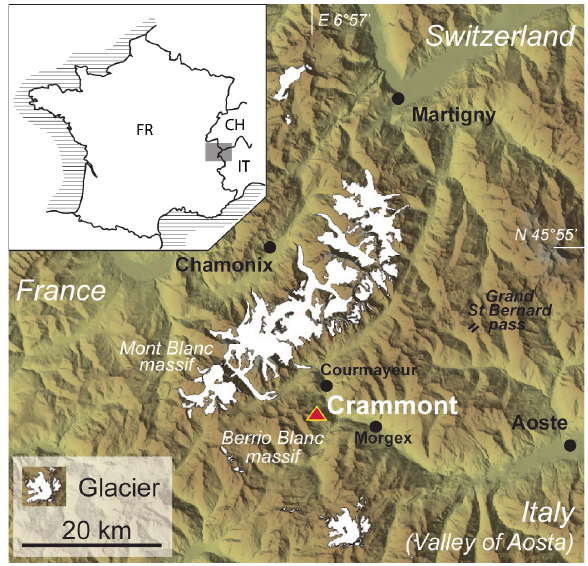
Fig. 2. General view of the Berrio Blanc massif from NE Fig. 2 (July 2009), with used toponymy. Source zone scar and main de- posit (light grey) of the Crammont rock avalanche are in the top center; secondary deposit in the two narrow torrent streams down to the Doire River. Note highway and village at the foot of the opposite side of the Doire valley.